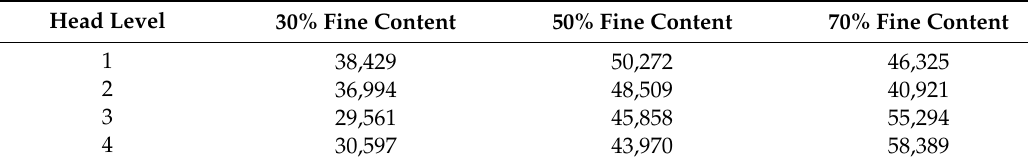
Table 22. Fine particle content change during seepage (40 – 75 µm).